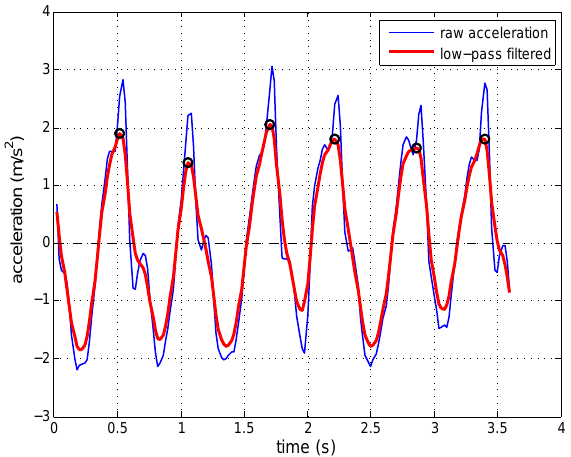
Figure 3. Acceleration data before and after